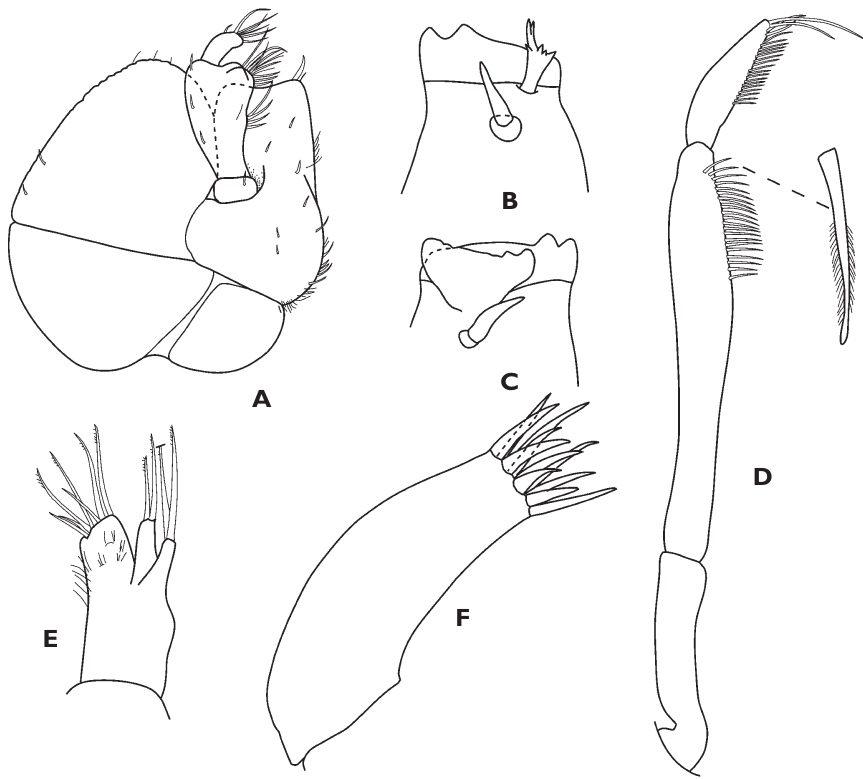
Figure 2. Heteroserolis pellucida sp. n. Paratype ♂ 10.5 mm, Is.6017. A maxilliped B right mandible C left mandible D mandible palp E maxillule F